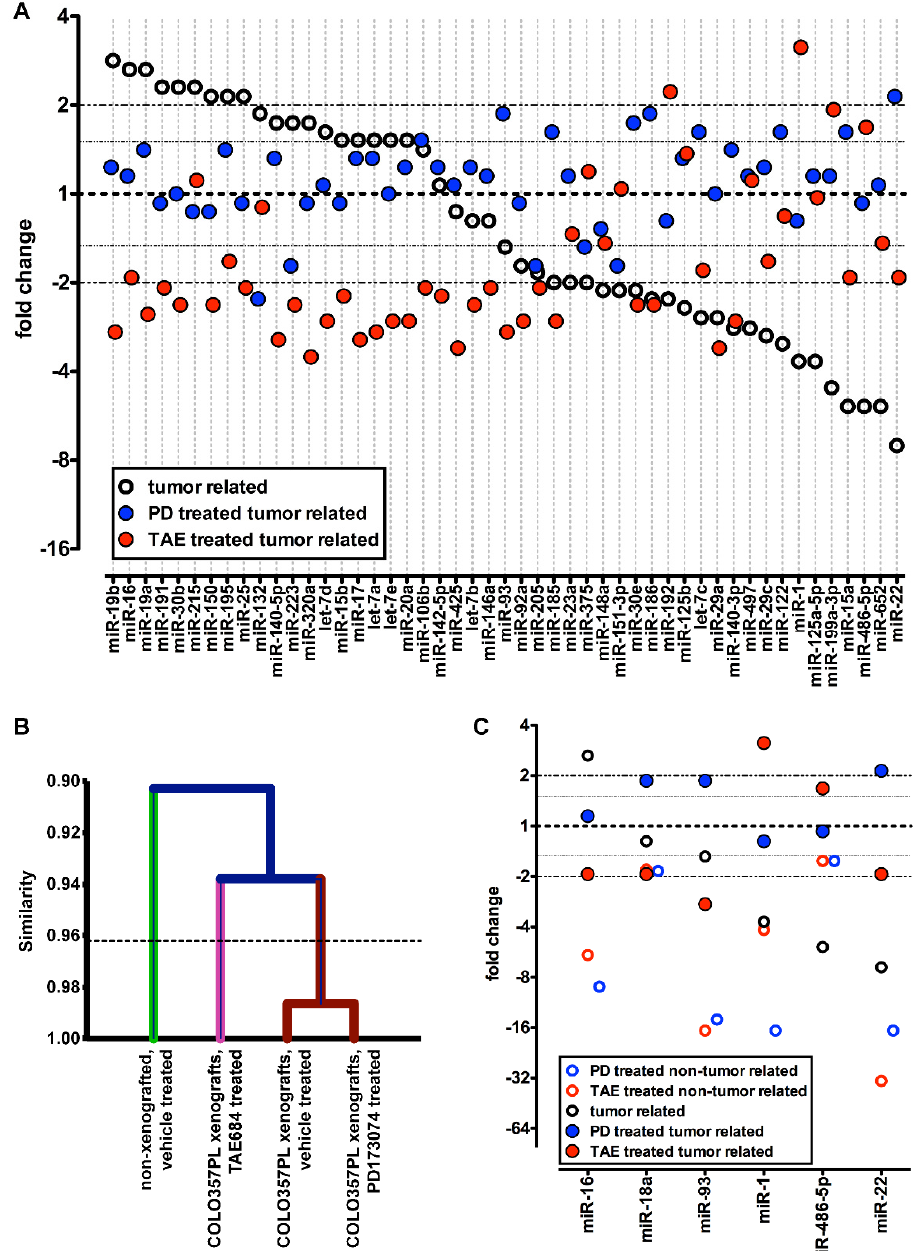
Figure 3. Serum miRs in nude mice with and without tumors and drug treatment. ( A ): Effect of tumor xenografts (black circles); fold changes of serum miRs in mice with COLO357PL tumors relative to controls without tumors. Effect of a 7-day drug treatment on serum miRs in COLO357PL tumor bearing mice (PD173074, blue symbols; TAE684, red symbols); fold changes in serum miRs after treatment relative to control treatment. qPCR was used to analyze 352 miRs, which were normalized for median Ct value. Fold changes are arranged by the expression of tumor-related miRs (black circles). Forty-nine serum miRs with Ct < 30 in every experimental group that were up- or downregulated ≥ two-fold in at least one of the comparisons are included. ( B ): Hierarchical clustering based on serum miR expression. The dotted line indicates p < 0.05. ( C ): Effect of PD173074 (blue circles) or TAE684 (red circles) treatment of mice without tumors. Six serum miRs were analyzed for expression in serum samples of nude mice without cancer that underwent short-term treatment. Data were normalized for U6 small nuclear RNA. Data from COLO357PL xenografted mice from panel ( A ) are included for